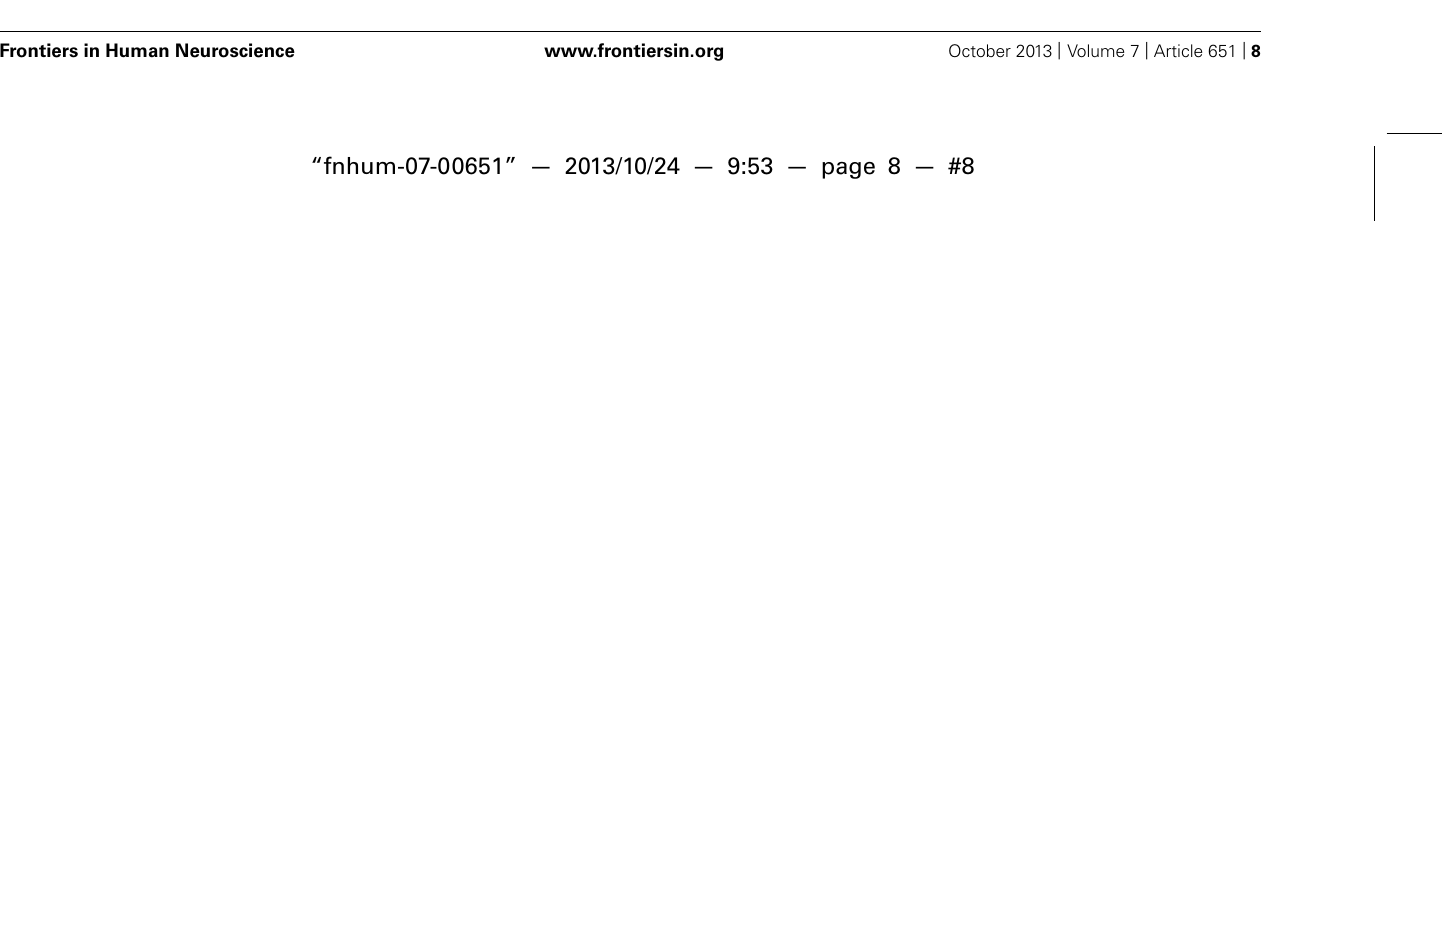
congruent condition, separately for each block. (C) Mean reaction times (lines) and error rates (bars) in the incongruent condition, separately for each block. Error bars represent the standard error of the